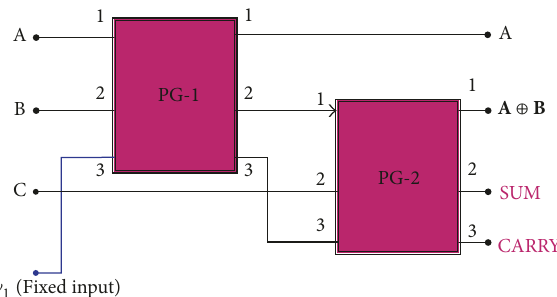
Figure 9: Optical full adder circuit using Peres